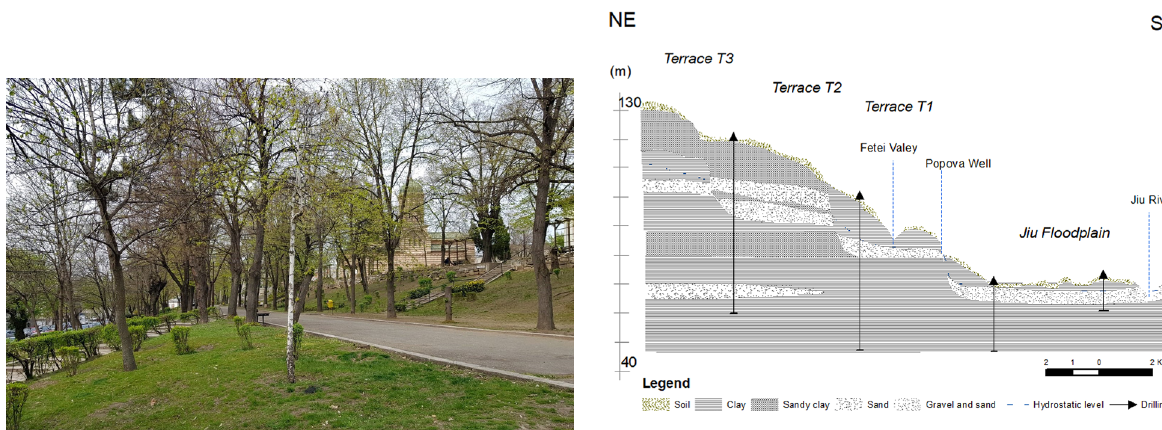
Fig. 7. lithological cross section on the left hillslope of